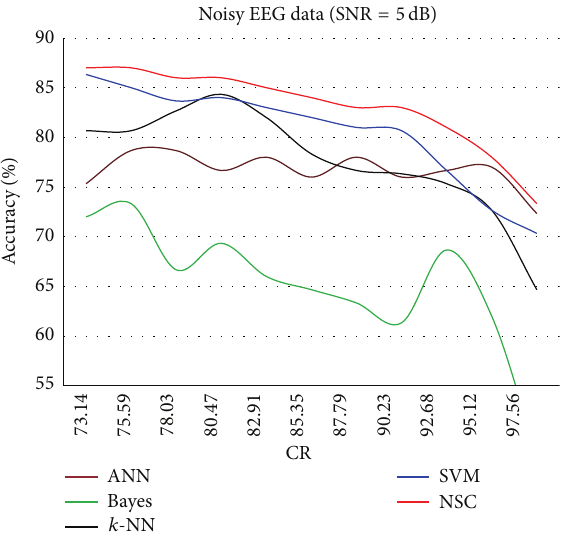
Figure 6: Classification accuracy against CR for SNR = 5 dB.